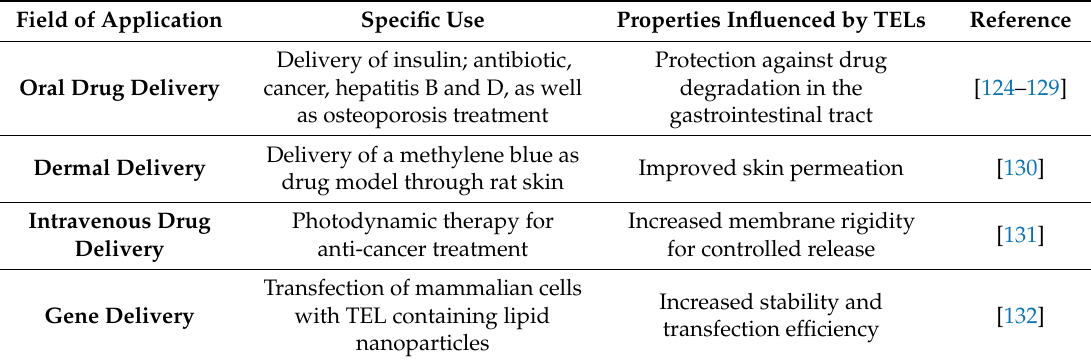
Table 3. Recently investigated applications of tetraether lipids (TELs) from Sulfolobales, in the field of drug and gene